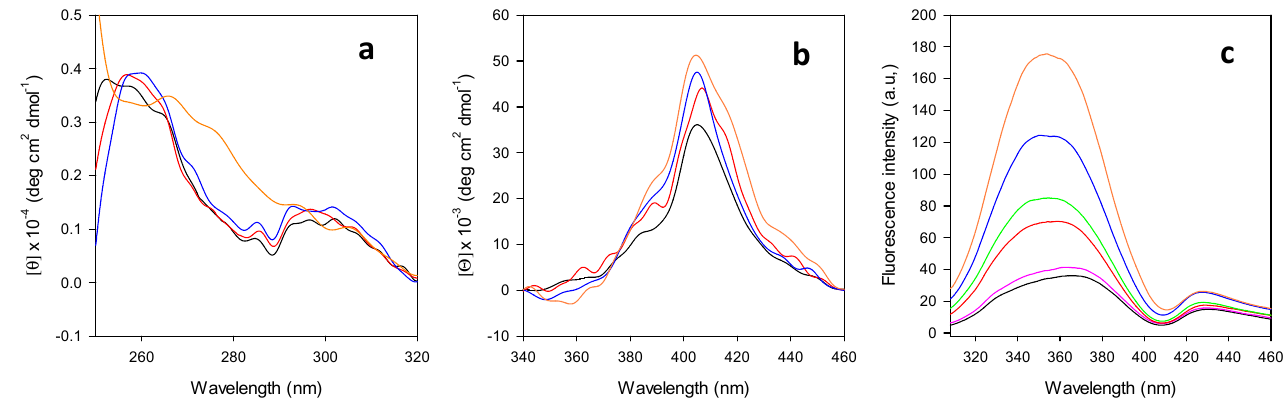
Figure 7. Spectra of M80A cytc at increasing DMSO concentration in 10 mM phosphate buffer, pH 7.0. ( a ) Near-UV CD; ( b ) CD in the visible region; ( c ) Fluorescence emission. Black: 0% DMSO; pink: 10% DMSO; red: 20% DMSO; green: 30% DMSO; blue: 40% DMSO; orange: 50% DMSO.